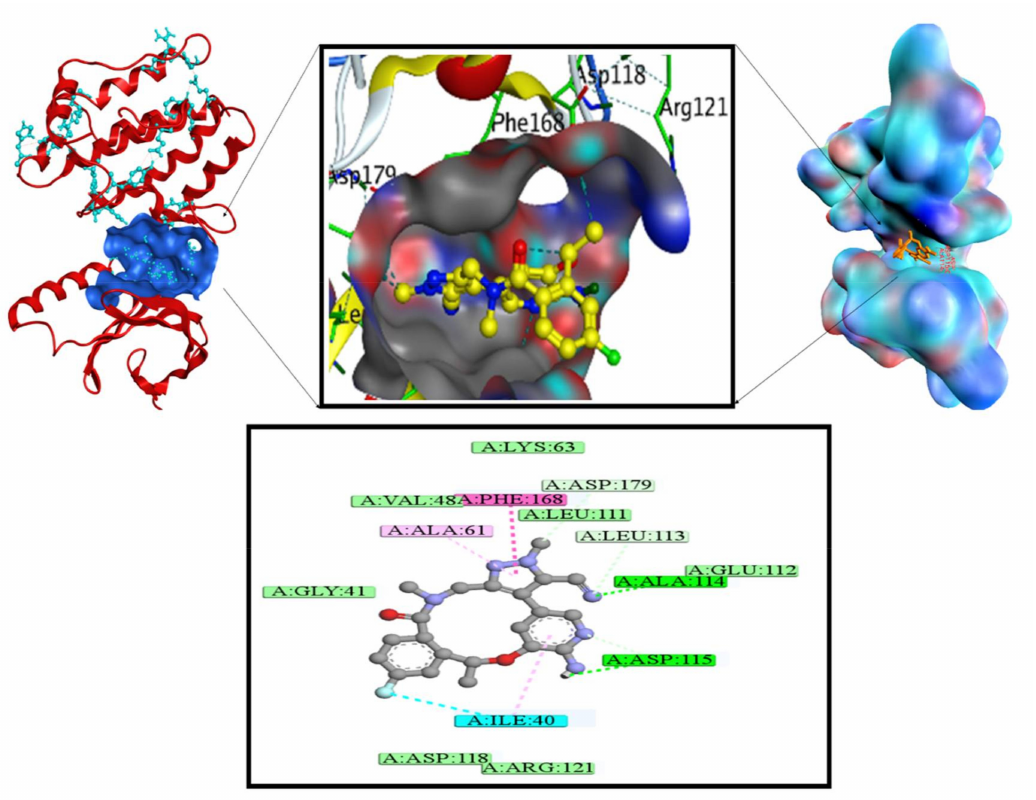
Figure 7. 2D and 3D interactions of NEK7–Dabrafenib